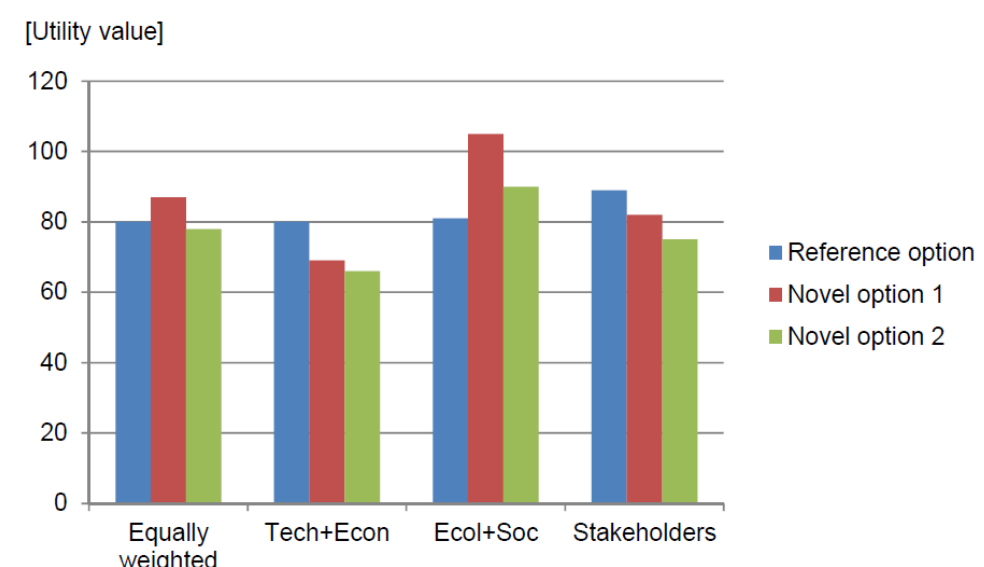
Figure 4. Utility values of water infrastructure options in model area B depending on weighting scenario (“Tech+Econ” = weighting scenario with emphasis on technological and economic category; “Ecol+Soc” = weighting scenario with emphasis on ecological and social category; “Stakeholders” = weighting scenario with the stakeholders’ weightings).